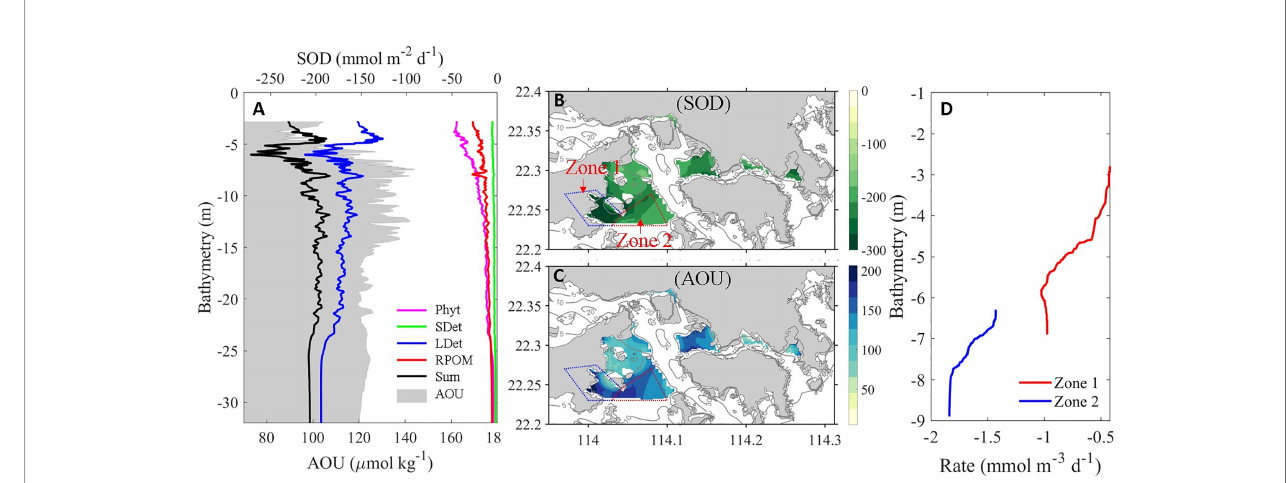
FIGURE 6 | (A) Bathymetry-dependent distribution of terms (equation 1) contributing to SOD and AOU (shaded values) in the bottom layer over the VH. Horizontal distributions of (B) SOD and (C) AOU in the bottom layer (averaged over 1 m above the bottom) over the VH where water depth is shallower than